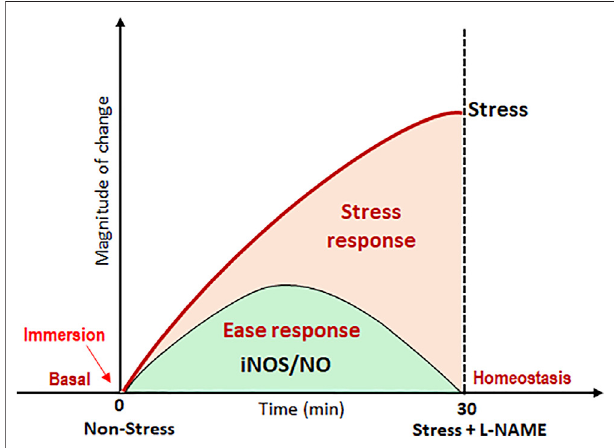
FIGURE 4 | Typical homeostatic pattern of stress response involves NKA-driven Na + homeostasis and ease response. Here, the response of NKA function was plotted when the fi sh was subjected to 30 min immersion stress againstthenonstressedcondition.Thehighestmagnitudeofionosmotic stress response is represented as the highest peak in the parabola when the fi sh were held at a 30-min time frame. L-NAME – induced activation of the iNOS/NO system in the ionocytes of stressed fi sh initiated a recovery response by lowering the magnitude of NKA-driven Na + transport. This ability of the iNOS/NO system to attenuate the hypoxemia-induced ionosmotic stress response depicts a major role of the iNOS/NO system as a biomarker for stress and ease response in fi